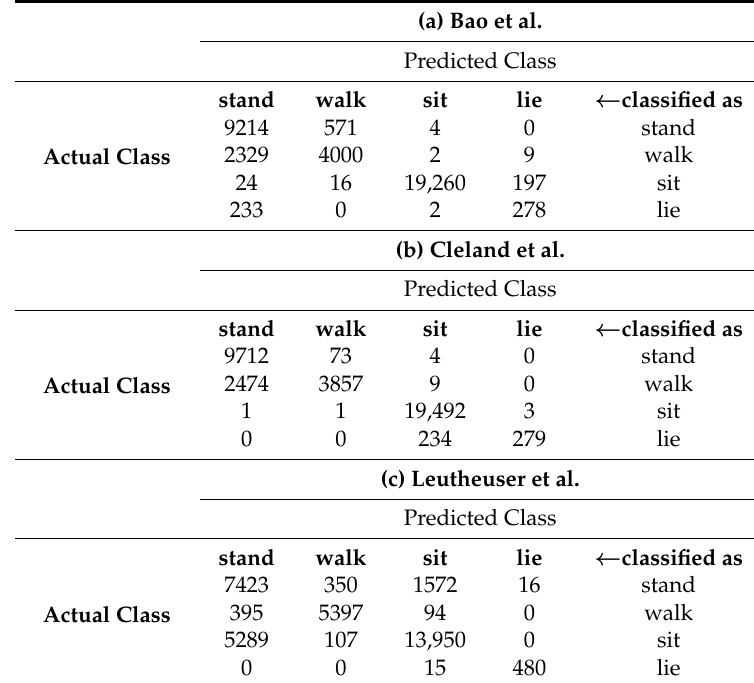
Table 6. Confusion matrix for the systems; ( a ) Bao et al.; ( b ) Cleland et al.; and ( c ) Leutheuser et al.; in the in-lab training/out-lab testing scenario.